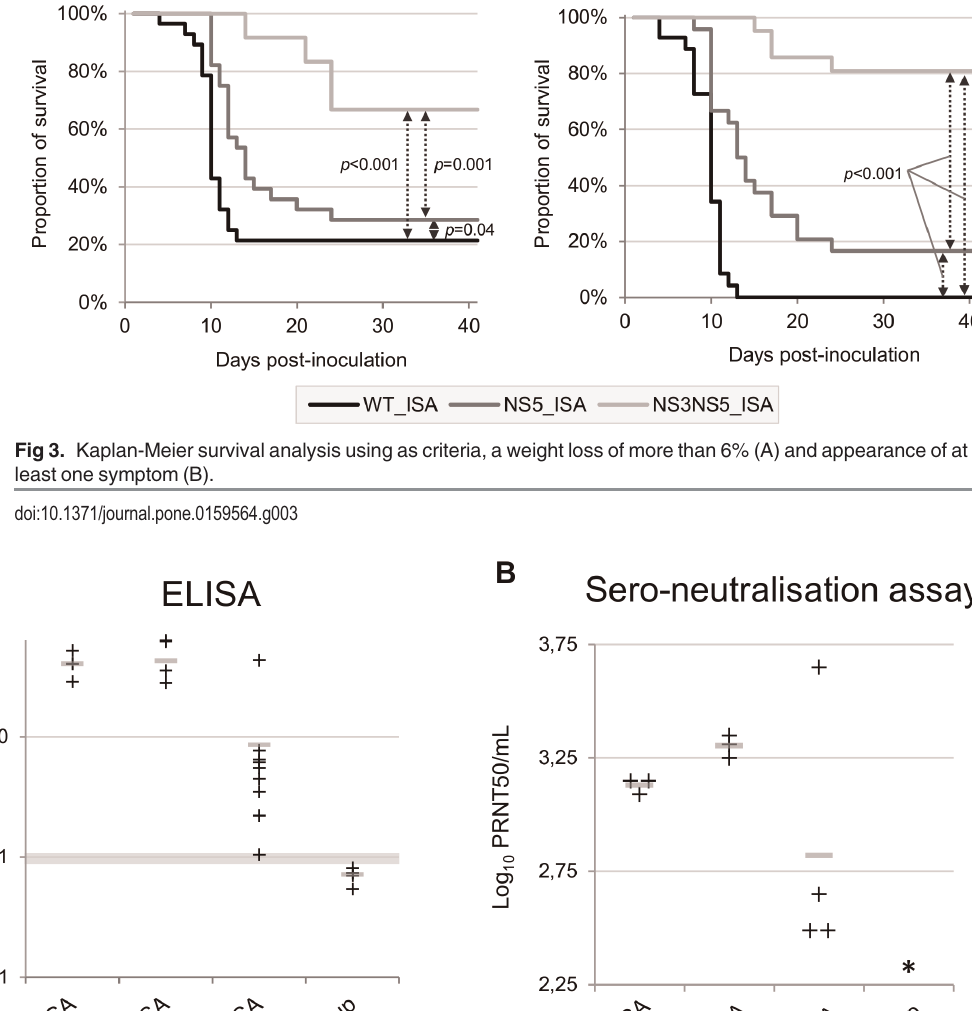
Table A. Genetic characteristics of the complete coding regions of WT_ISA virus, NS5_ISA